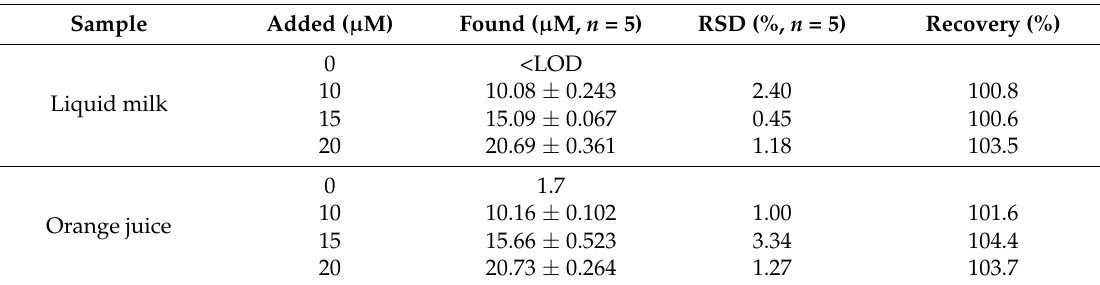
Table 2. Determination results of BPA in real